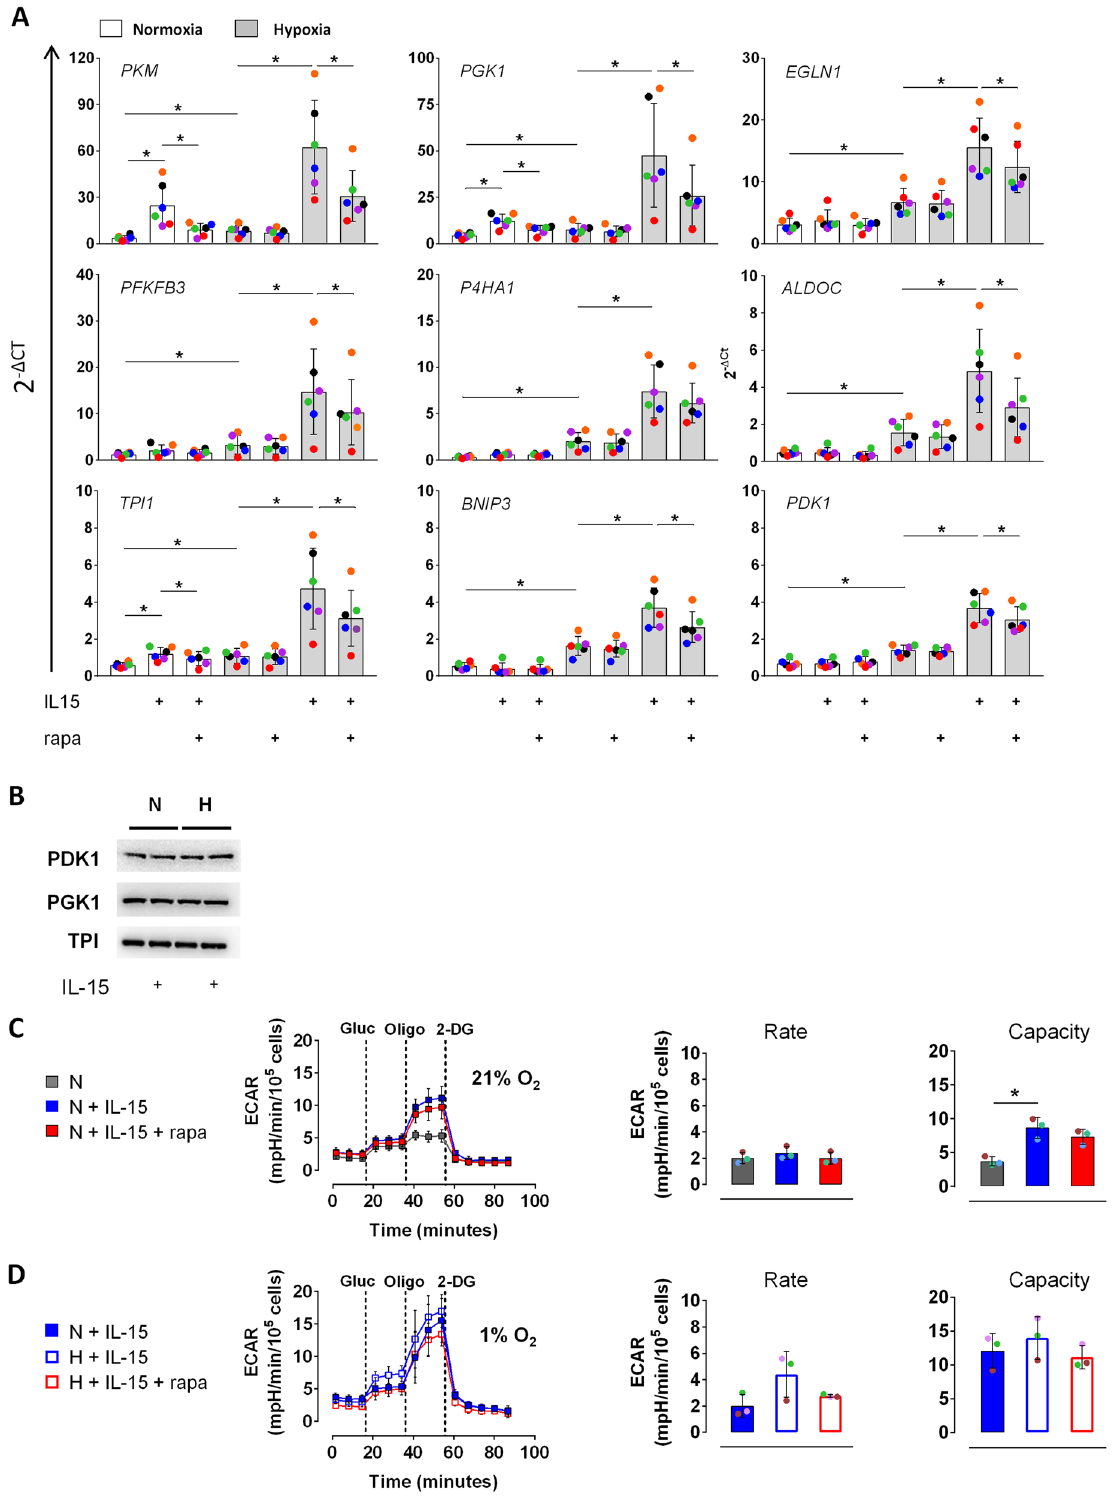
Figure 2. The glycolytic response of NK cells to priming and hypoxia partially depends on mTORC1. ( A – D ) NK cells incubated under normoxia (N, 21% O 2 ) or hypoxia (H, 1% O 2 ) for 16 h were primed with IL-15 for additional 6 h in the presence or absence of rapamycin (rapa) as indicated. ( A ) Expression analysis of hypoxia-regulated genes by RT-PCR. Mean values ± SD for linearized quantities (2 −ΔCt ) are shown (n = 6). * p < 0.05, Wilcoxon signed-rank test. ( B ) Immunoblotting with antibodies against PDK1, PGK1 and TPI. Aliquots of the same samples were analyzed as in Fig. 1d, lanes 1, 2, 6 and 7. The blot reflects one representative experiment of three performed. ( C ) and ( D ) Glycolytic parameters. Extracellular acidification rate (ECAR) values were measured over time under atmospheric oxygen, i.e., 21% O 2 ( C ) or in a hypoxic chamber at 1% O 2 ( D ). Each data point represents an average ± SD of three independent experiments. Dashed lines indicate additions of glucose (Gluc), oligomycin (Oligo), and 2-deoxyglucose (2-DG). * p < 0.05, Friedman test with Dunn’s test for post-hoc pairwise